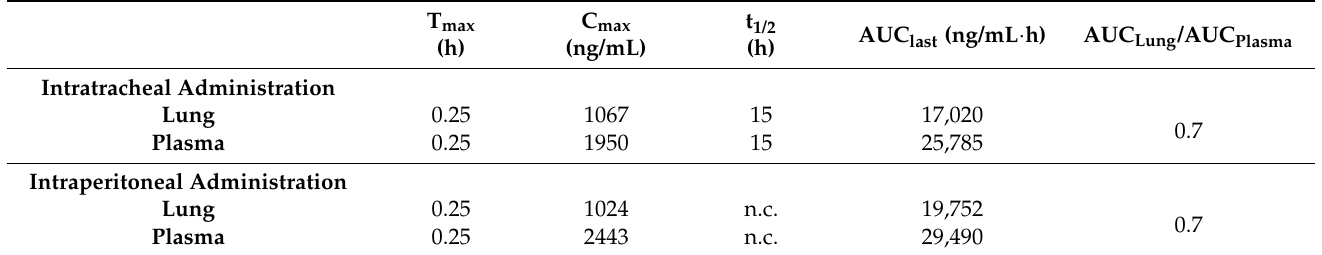
Table 2. Pharmacokinetic parameters after either intratracheal or intraperitoneal administration of rosiglitazone (1 mg/kg) to premature rabbit